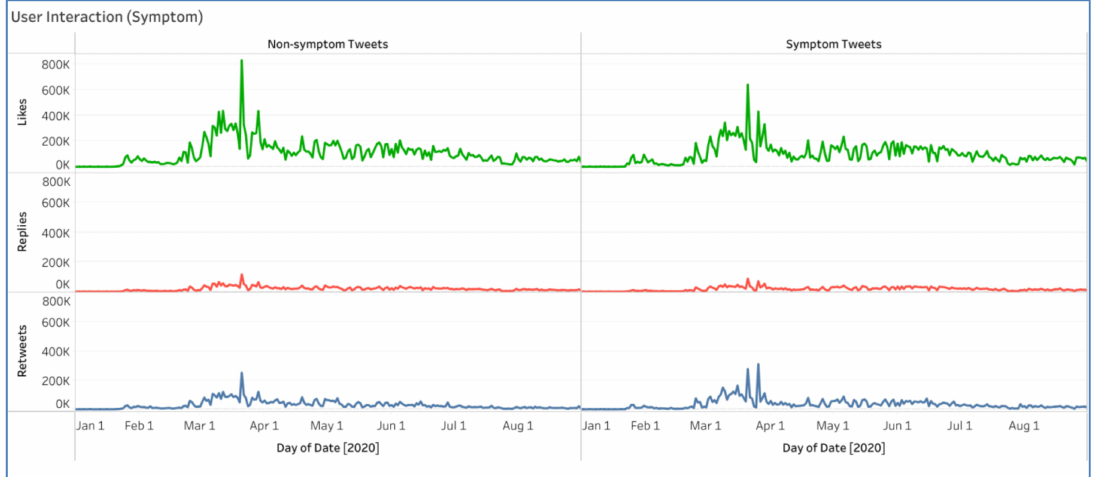
Figure 11. User Interaction